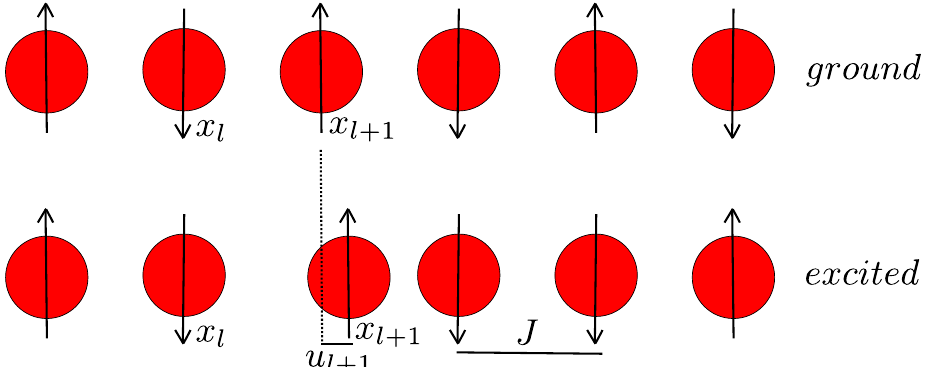
Figure 3. Schematic representation of the chain of electrons suitable as a starting point to describe a one-dimensional Wigner molecule in the regime of strong